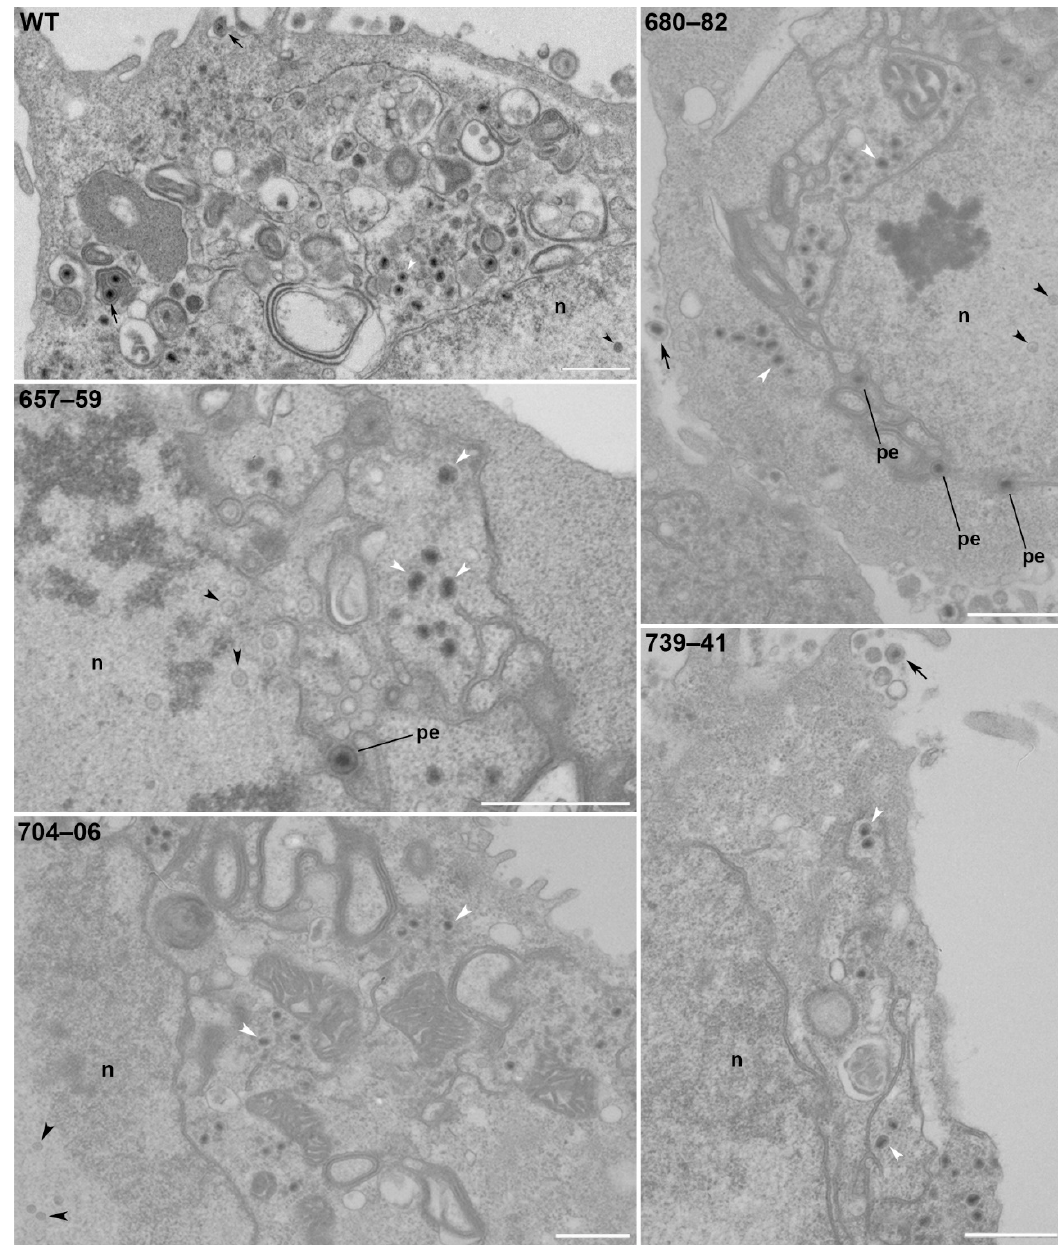
Figure 6. AAA substitutions at residues 657–59, 680–82, 704–06, and 739–41 of pUL37 result in significant reduction of mature enveloped virus particles. Vero cells were infected with viruses specifying AAA substitutions or WT and TEM analysis of infected cells was carried out 18 hours post-infection. In the mutant-infected cells, there was an accumulation of capsids in the nucleus (n) (black arrowheads) and electron-dense DNA-filled capsids in the cytoplasm (white arrowheads). Perinuclear enveloped capsids were observed in some infected cells (pe). Occasionally, a mature particle was observed leaving the cell infected with AAA mutant viruses (arrow). Cytoplasmic capsids surrounded by an envelope were not observed in these cells, whereas they are clearly evident in WT pUL37-infected cells. Scale bar = 1 µm.